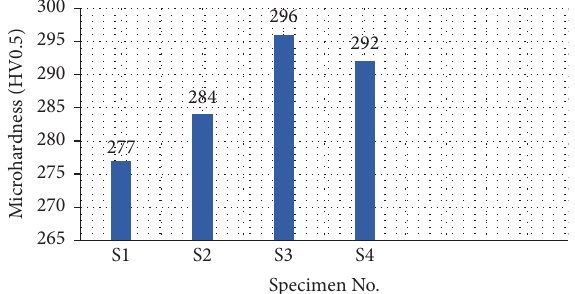
Figure 6: Microhardness (HV) for samples produced by SLM. Table 2: Te sample produced with constant layer thickness of 30 µ m, hatch distance of 70 µ m, and laser power of 200W. No. of